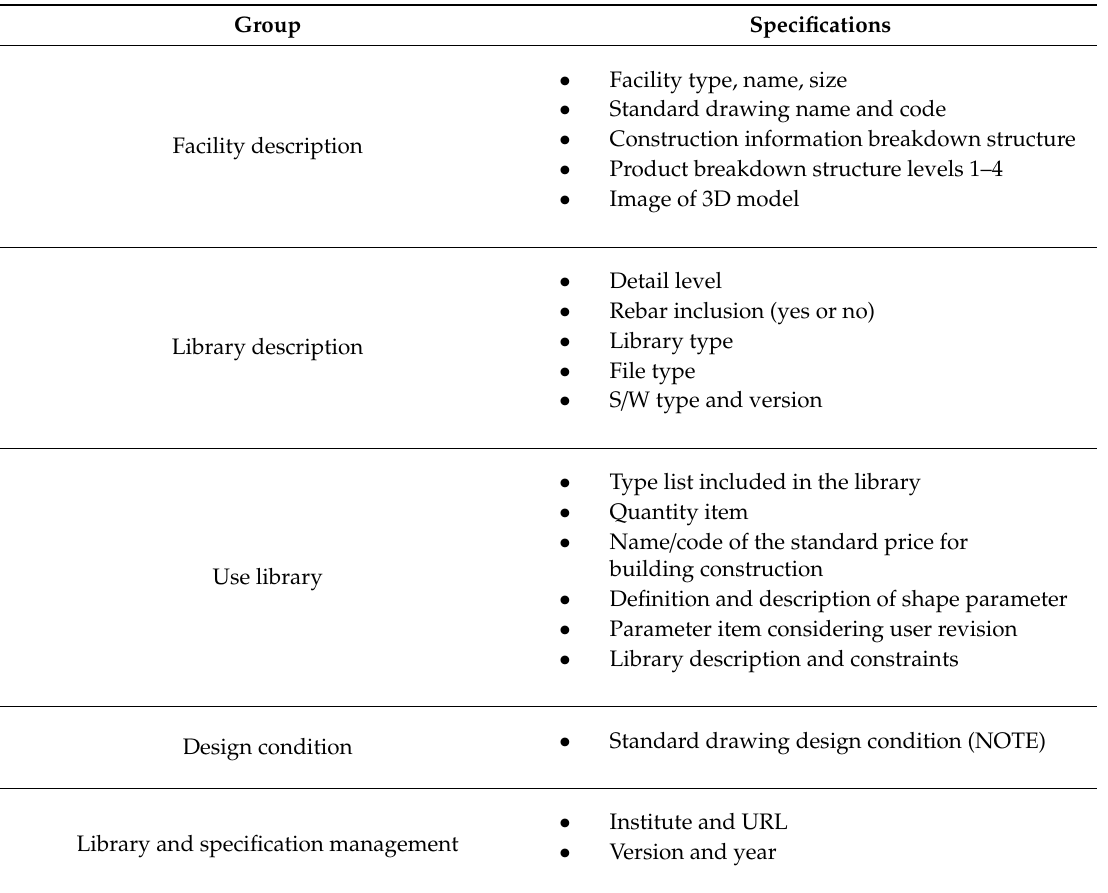
Table 6. Description of